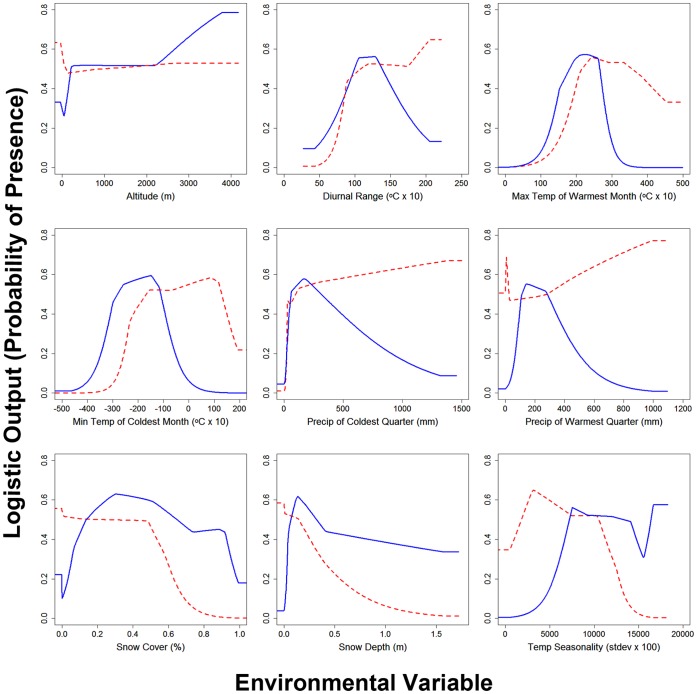
Individual response curves of the Canada lynx and bobcat for environmental variables.Response curves for Canada lynx (blue, solid line) and bobcat (red, dotted line) are given with the y axis representing probability of occurrence over the variables in units provided by the source of the data. The curves represent models developed for each species using only the corresponding variable.